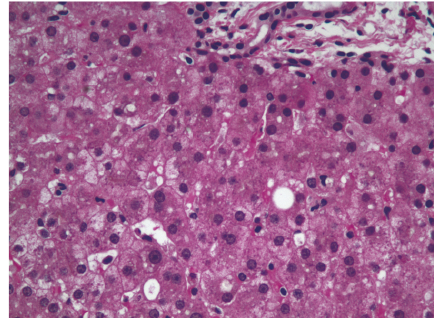
Figure 3: Liver biopsy showed focal steatosis, focal nonspecific chronic inflammation, and a nonspecific increase in the lipochrome pigment in